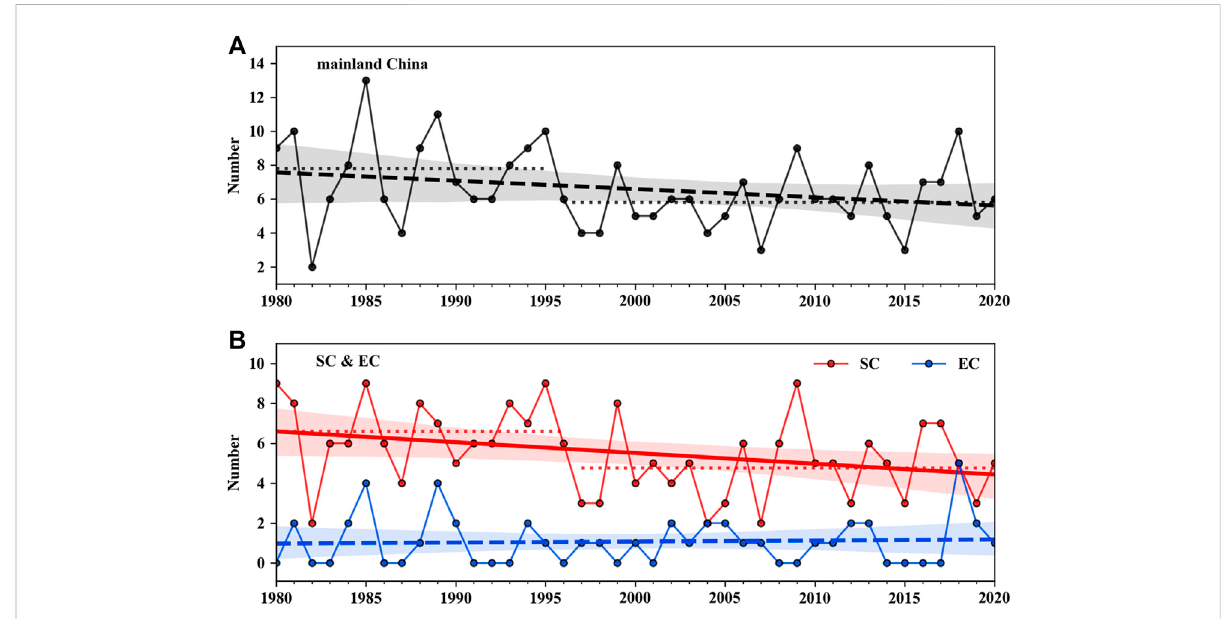
FIGURE 2 Thetime series andthelinear regression fi toftheTCs ’ landfalling frequencyover (A) mainlandChina and (B) SCand ECfrom1980 to2020. The solid (dashed) trend lines represent signi fi cant (insigni fi cant) trends at the 90% con fi dence level by Student ’ s t test. Linear trend lines are shown with their 95% two-sided con fi dence intervals (shaded). The dotted lines indicate the mean landfall frequency over different periods.